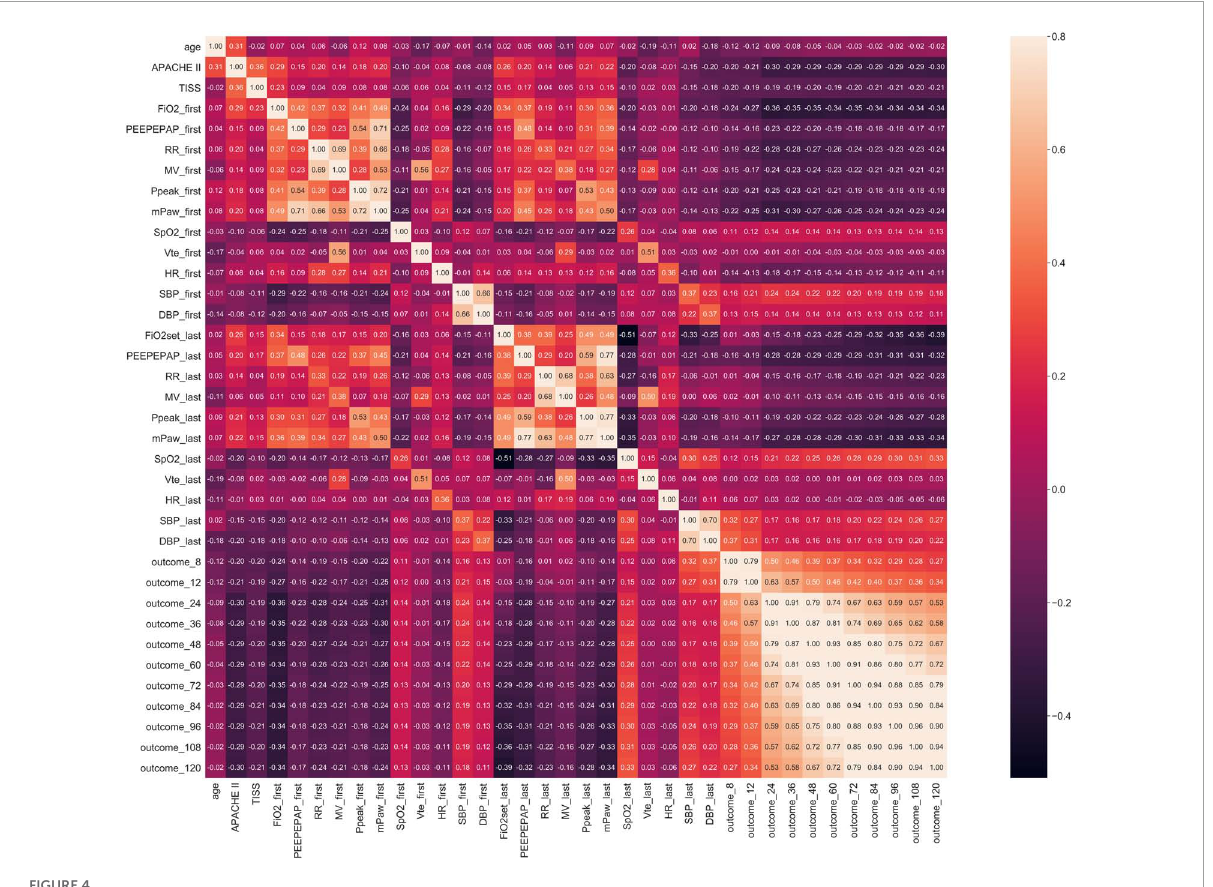
FIGURE4 Stage 1 Spearman